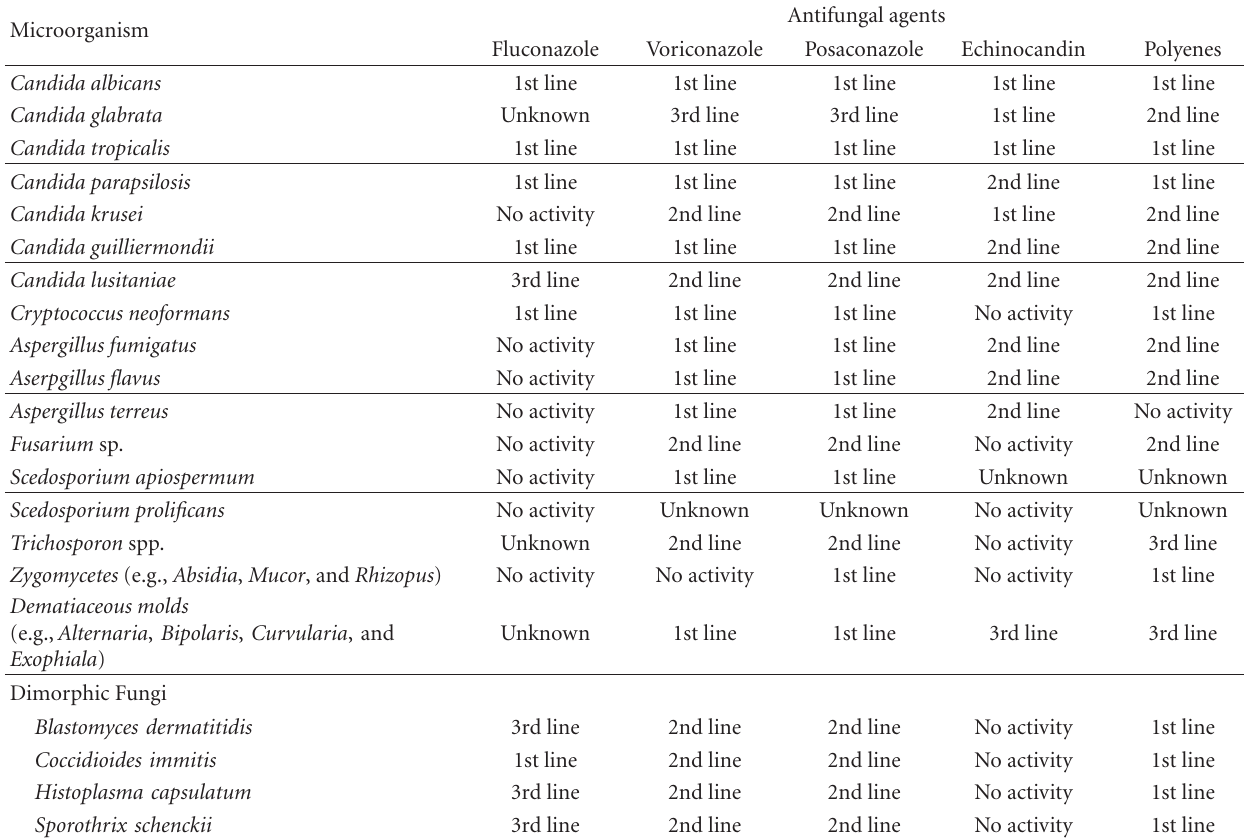
Table 2: Pathogenic fungi and the antifungal agents in vitro activity ∗∗